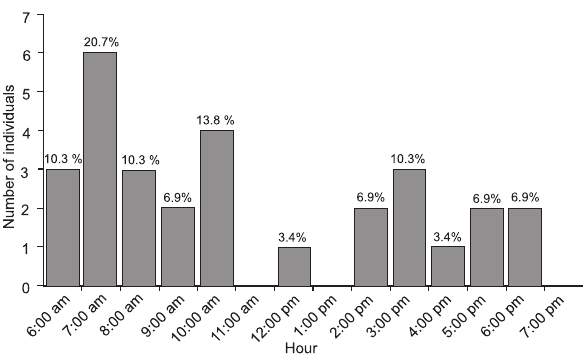
).Figure 2. Daily activity cycle of Mabuya macrorhyncha (N = 29) in Grussaí, municipality of São João da Barra, state of Rio de Janeiro, Brazil. Frequency (%) of occurrence is shown above